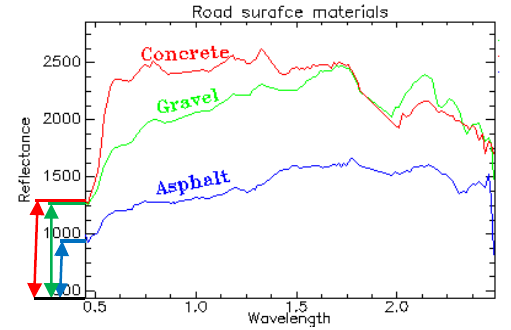
Figure 4. Asphalt, concrete and gravel spectra.